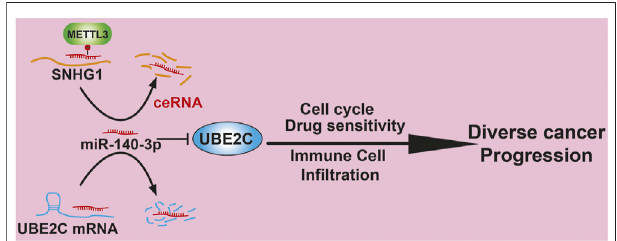
FIGURE 11 | Proposed model of the mechanism underlying the expression andfunctionofMETTL3/lncRNA-SNHG1/miRNA-140-3p/UBE2C Axis in